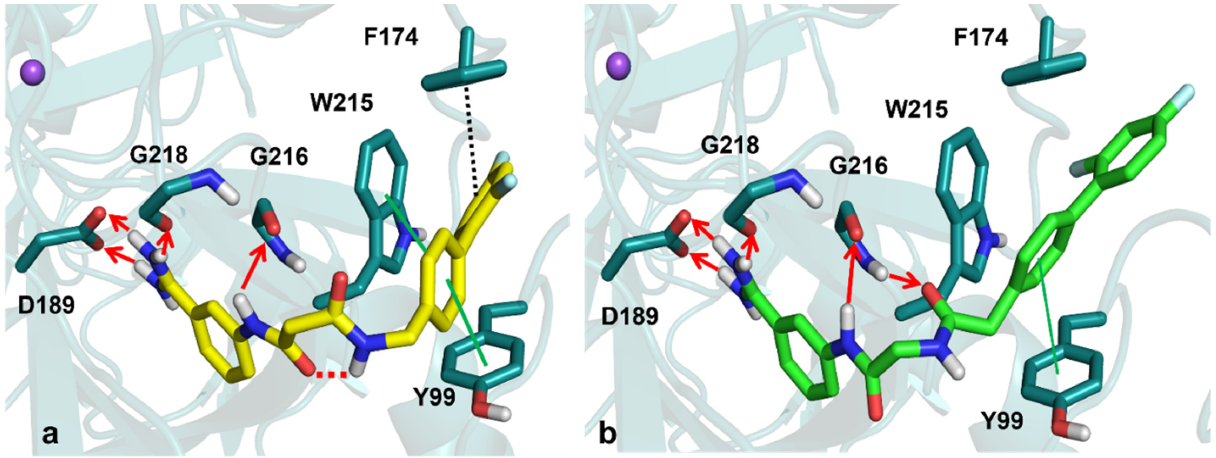
Figure 2. Panels ( a , b ) report the top-score docking poses of compounds 19h and 4c , respectively. Hydrogen bonds, π−π interactions, and hydrophobic contacts are represented as red arrows, and green and dashed black lines, respectively.